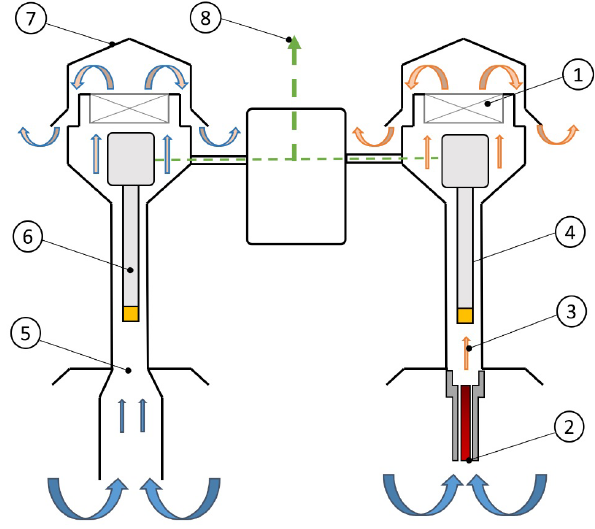
Figure 1. Schematic of the improved design of Genthon et al. (2017) for measuring atmospheric moisture, even when it is above saturation. Air is aspirated in a ventilated radiation shield (1) through a heated inlet (2). Its relative humidity and temperature (3) are measured with a HMP155 thermohygrometer (4). At the same time, the air is also aspirated through an unheated inlet (5), and the ambient temperature is measured by a second HMP155 instru- ment (6) set in a separate shield (7). Data from both HMP155 in- struments are collected by a common data logger